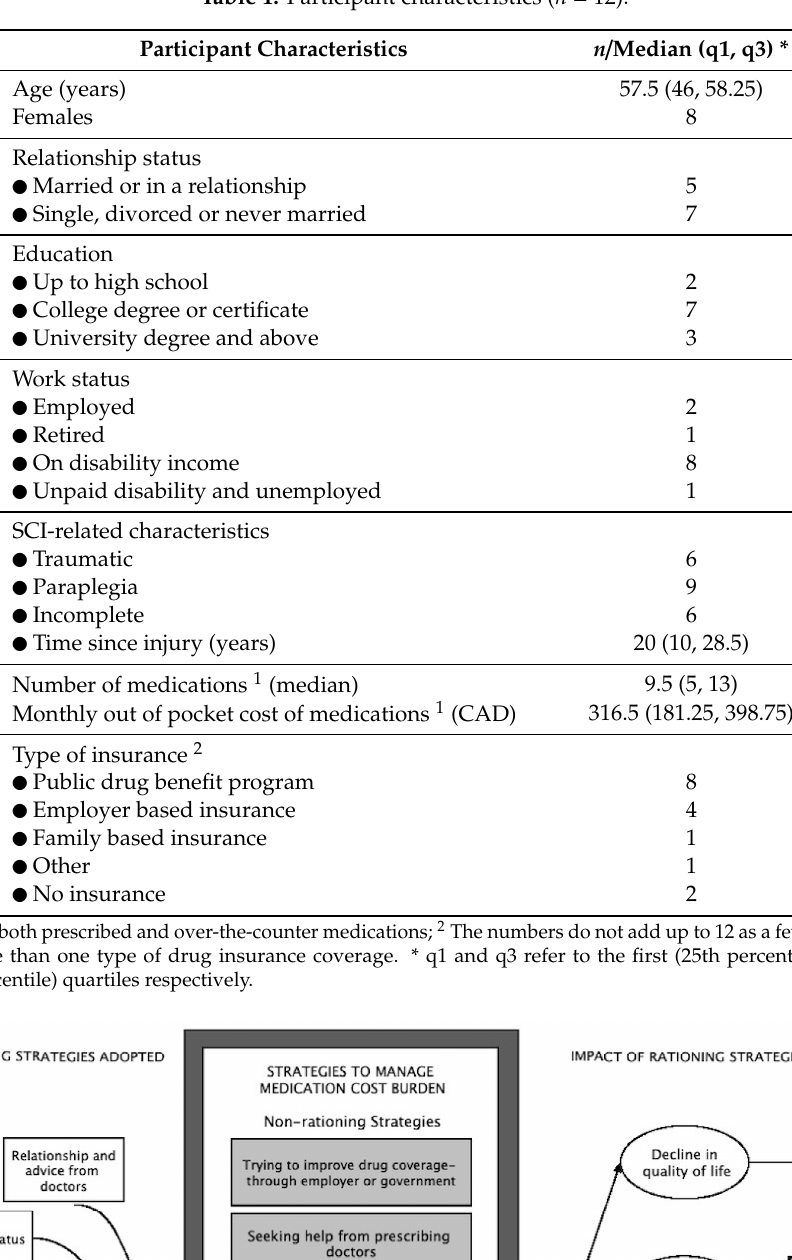
Table 1. Participant characteristics ( n = 12).